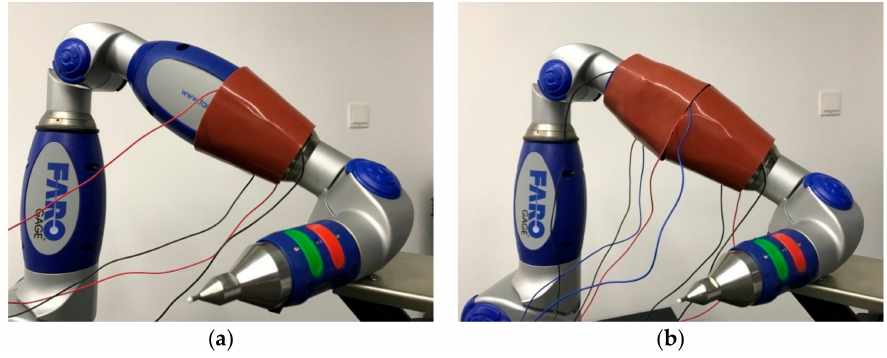
Figure 14. Sensor wrapping with: ( a ) one sensor; ( b ) two sensors.